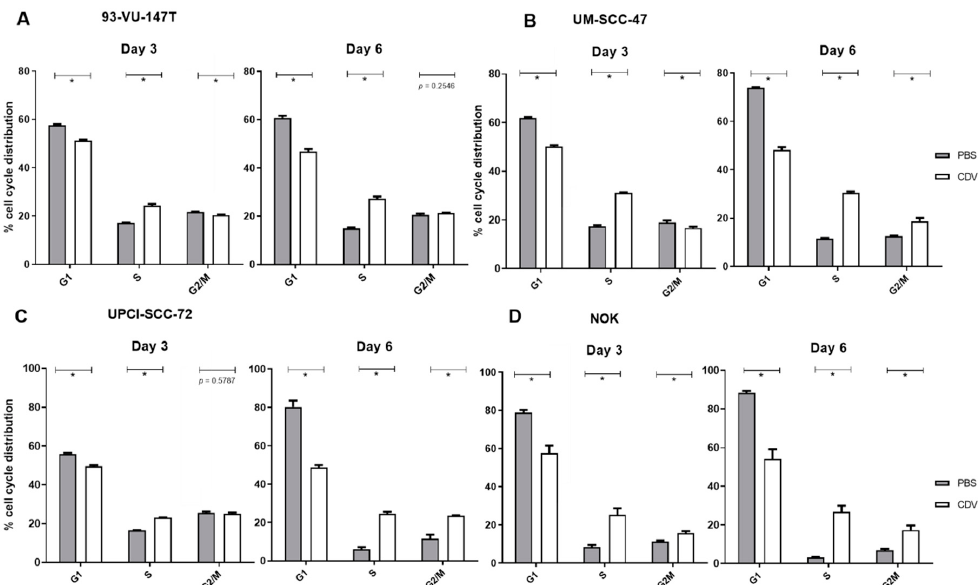
Figure 4. Cell cycle distribution of the HNSCC cell lines and NOK treated for 3 and 6 days with CDV or not treated (PBS). ( A ) 93-VU-147T, ( B ) UM-SCC-47, ( C ) UPCI-SCC-72, ( D ) NOK. Statistical significance was indicated as follows: p < 0.05 (*). The experiments were performed in triplicate. This was further confirmed by cyclin B1 immunostaining in CDV treated cell lines, showing an increase in intensity as well as the number of cyclin B1 positive cells after 6 days of CDV treatment (Figure 5). The most significant increase of cells in the G2/M phase after 6 days was seen for UM- SCC-47 and NOK. These cell lines showed also the most significant increase in cyclin B1 intensity after 6 days treatment.